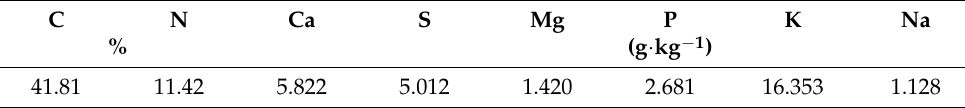
Table 3. Chemical composition of sheep